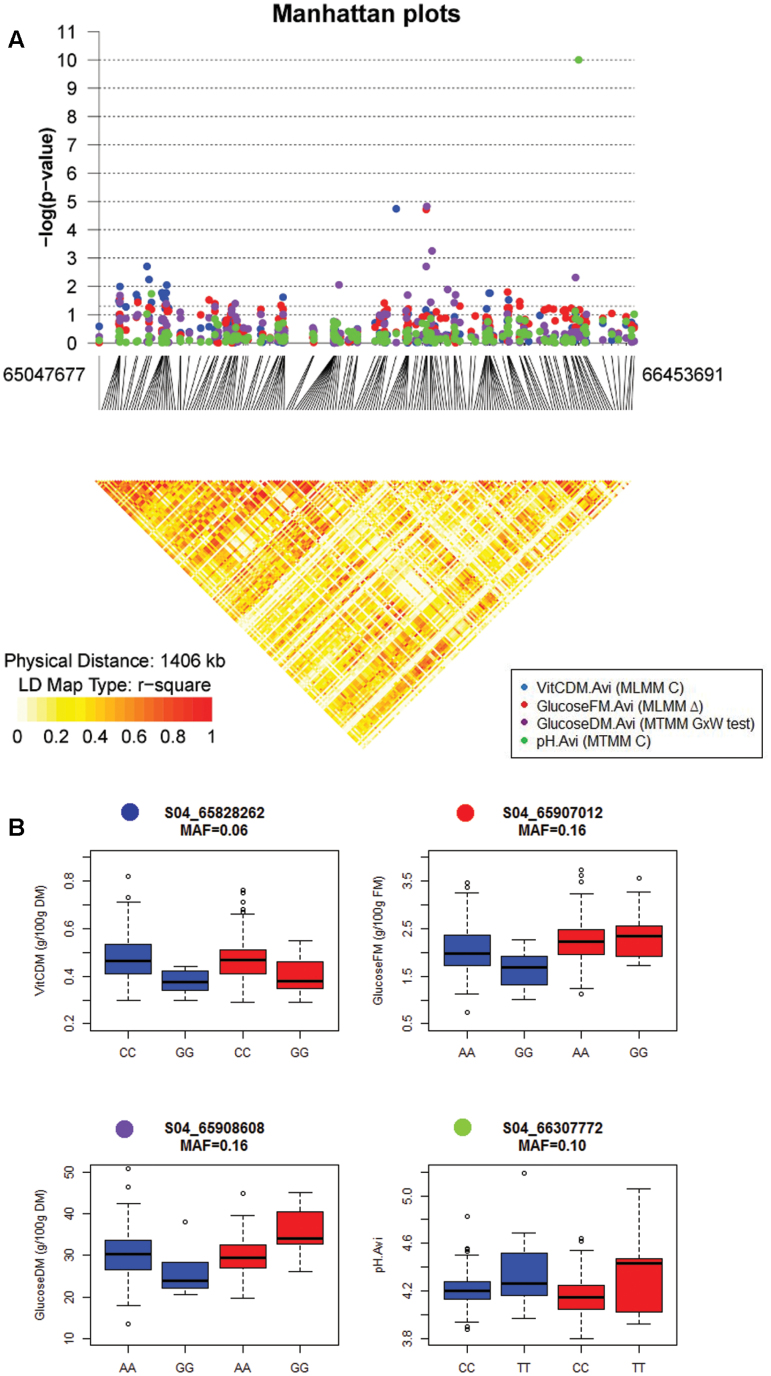
Focus on QTLs detected for fruit quality traits at the bottom of chromosome 4. (A) Manhattan plot displaying the –log10(P-values) (y-axis) over genomic positions (x-axis) in a window of 1.46 Mbp corresponding to the common confidence interval of QTLs detected for VitCDM.Avi (MLMM control condition, blue), GlucoseDM.Avi (MTMM GxW test, purple), GlucoseFM.Avi (MLMM ∆, red), and pH.Avi (MLMM control, green) on chromosome 4 in the GWA population. P-values <10–4 were considered as significant (4 in logit values). The pairwise LD heatmap was drawn using the R package ‘snp.plotter’ (Luna and Nicodemus, 2007). (B) Box-plot of the allelic effects for the four associated markers: S04_65828262 (VitCDM, ‘control specific’), S04_65907012 (GlucoseFM, ‘antagonist’), S04_65908608 (GlucoseDM, ‘antagonist’), and S04_6630772 (pH, ‘control specific’). Blue: allelic effects under control conditions. Red: allelic effects under drought conditions.